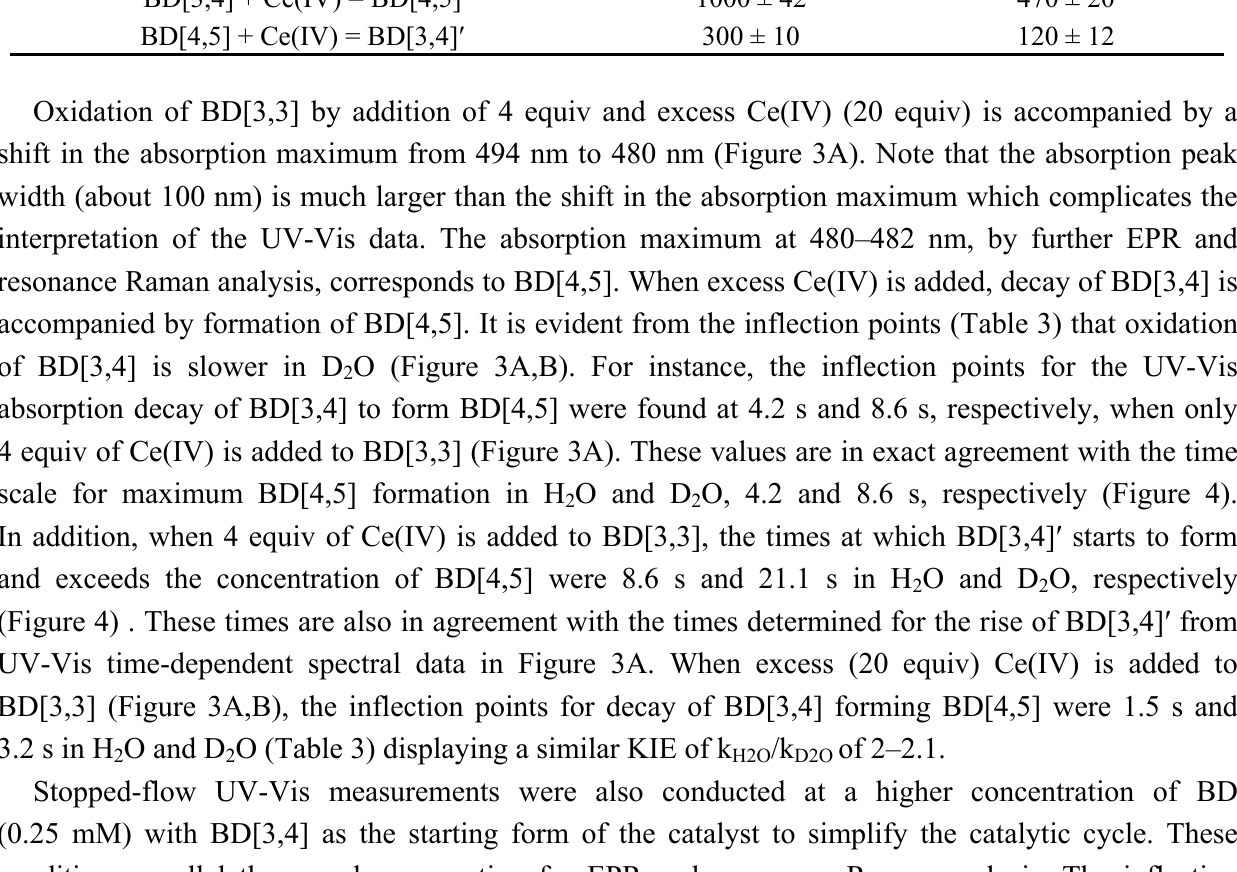
and DNO at pH = 1. UV-Vis absorbance curves and 3 3